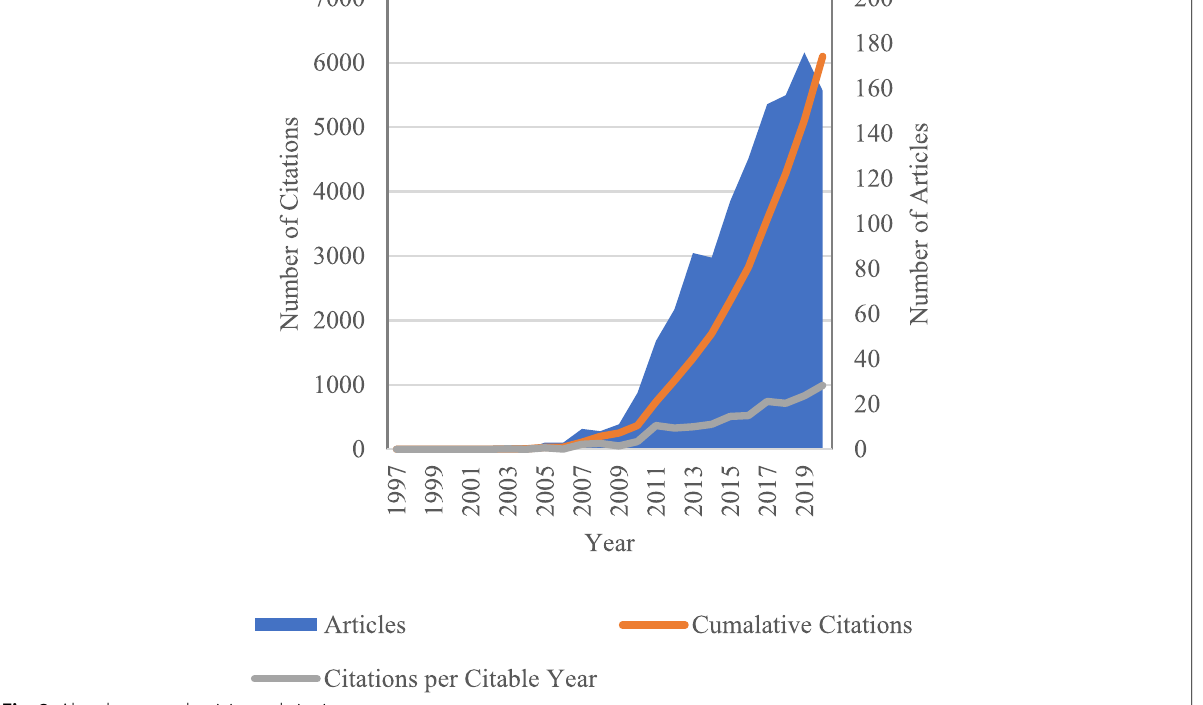
Fig. 8 Absorbent, productivity and citations